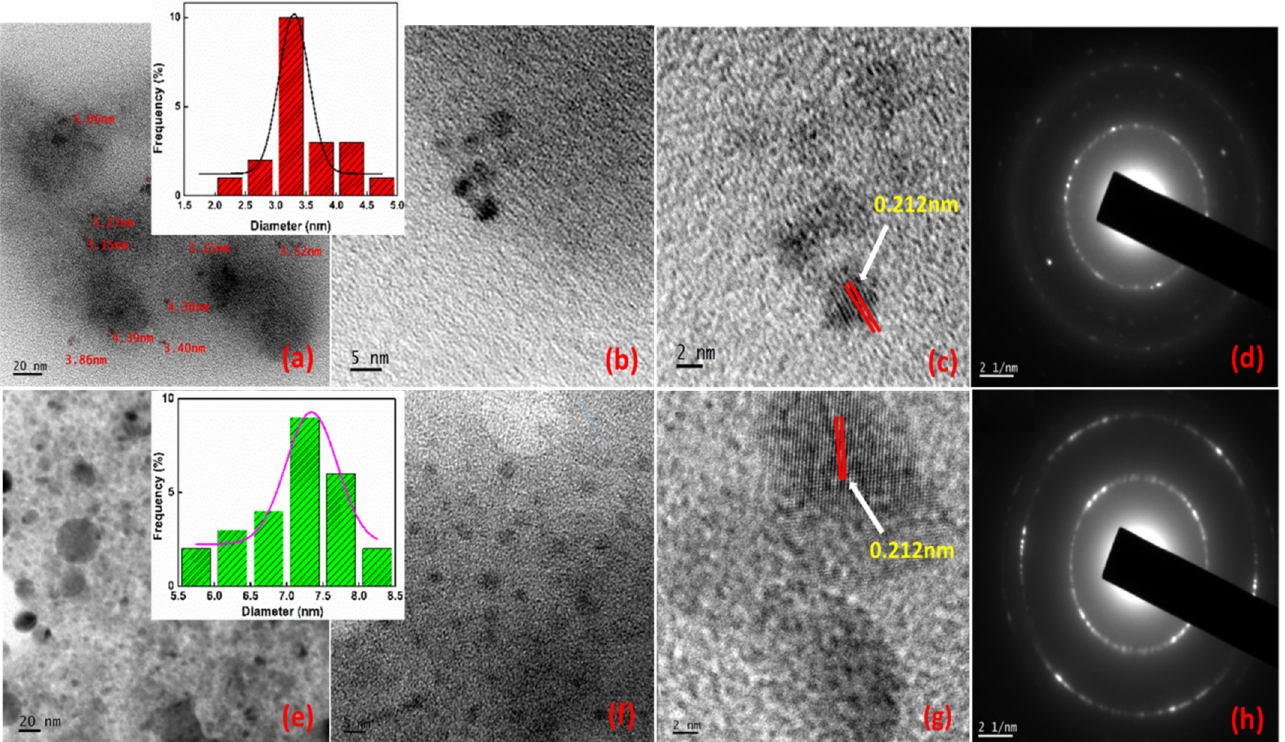
Figure 2. TEM and HRTEM images of ( a – d ) GQD@355 nm and ( e – h ) GQD@532 nm.